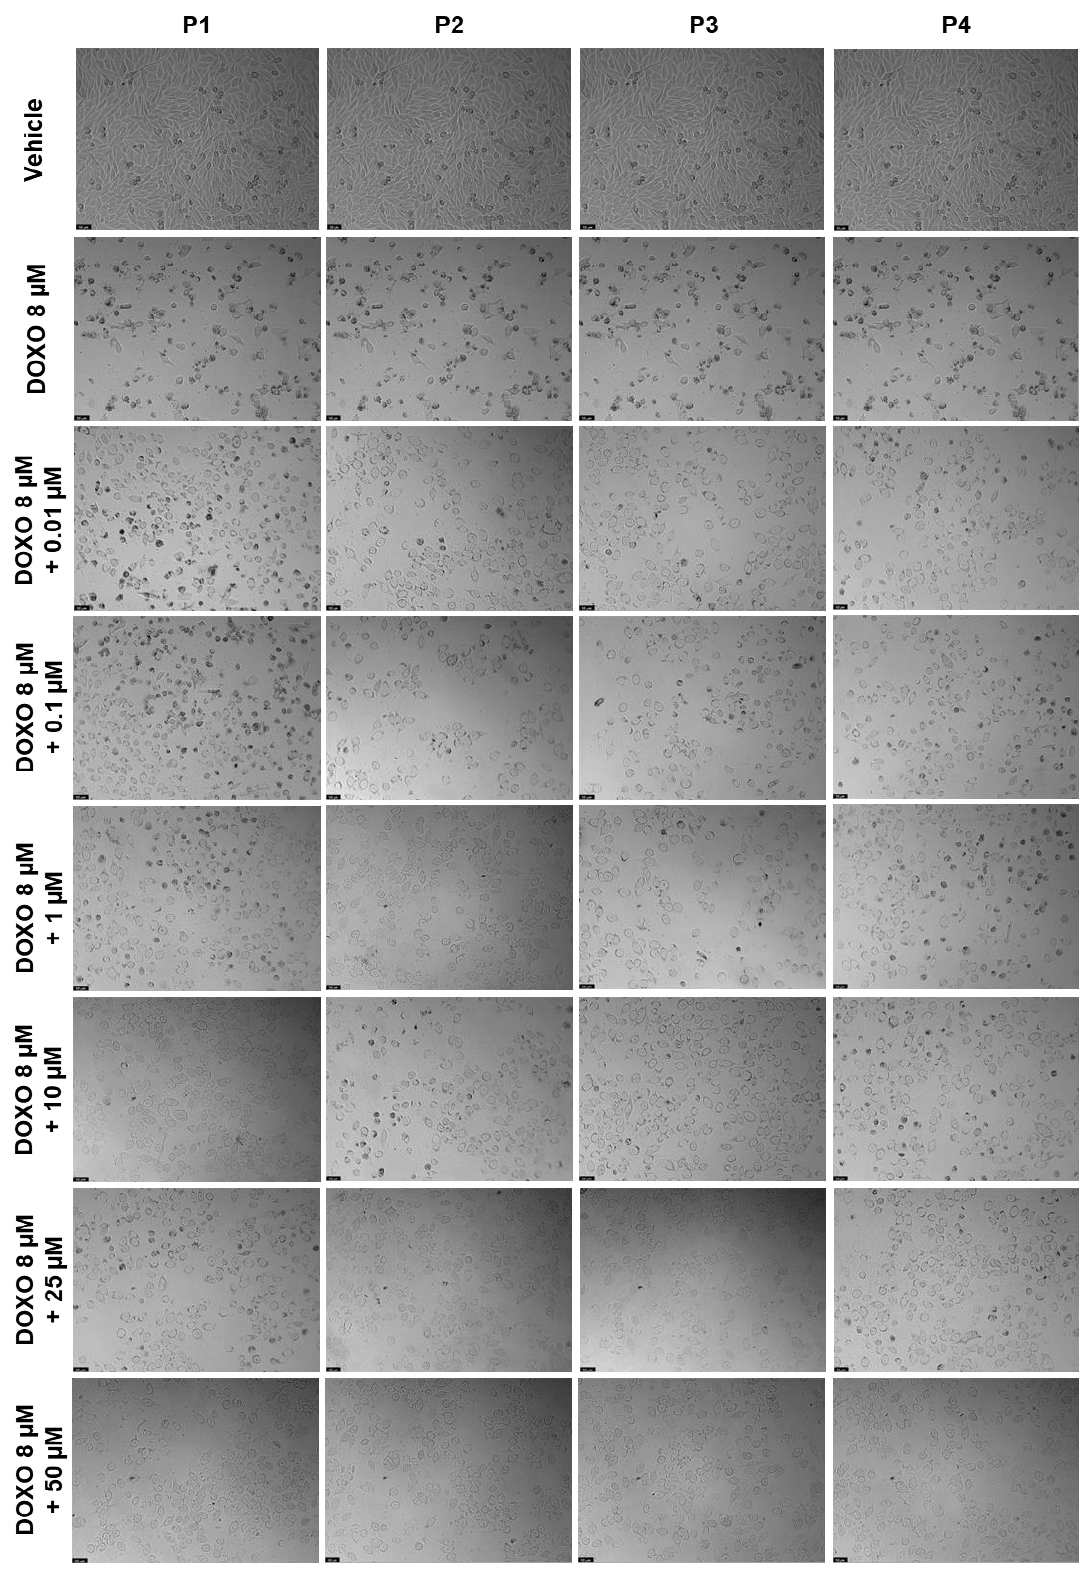
Figure 19. Morphological evaluation of PC-3 after exposure to a combination of 8 µ M of DOXO with increasing concentrations of P1–P4 (0.01–50 µ M) for 48 h. Both substances were added at the same time. Control cells were treated with the vehicle (0.01% DMSO). These images are representative of three independent experiments. Scale bar is 200 μM.